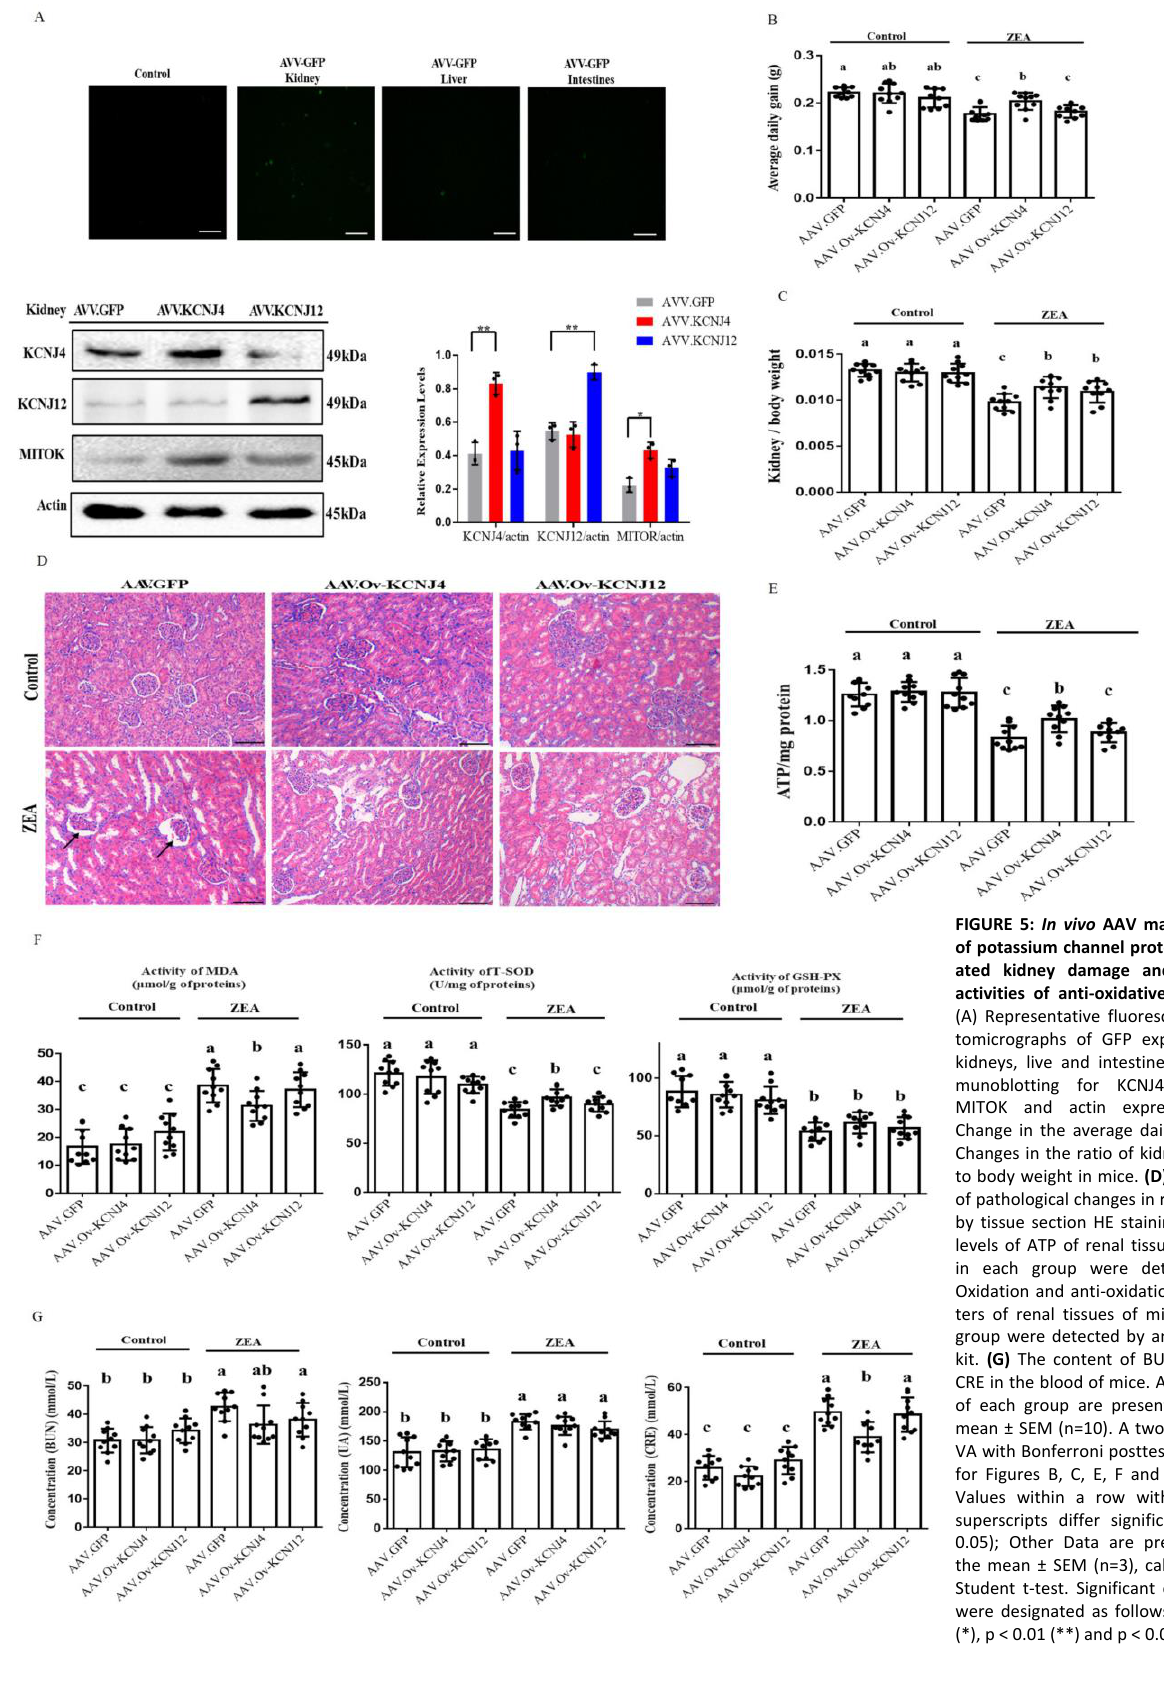
Cell Stress | MAY 2023 | Vol. 7 No. 5